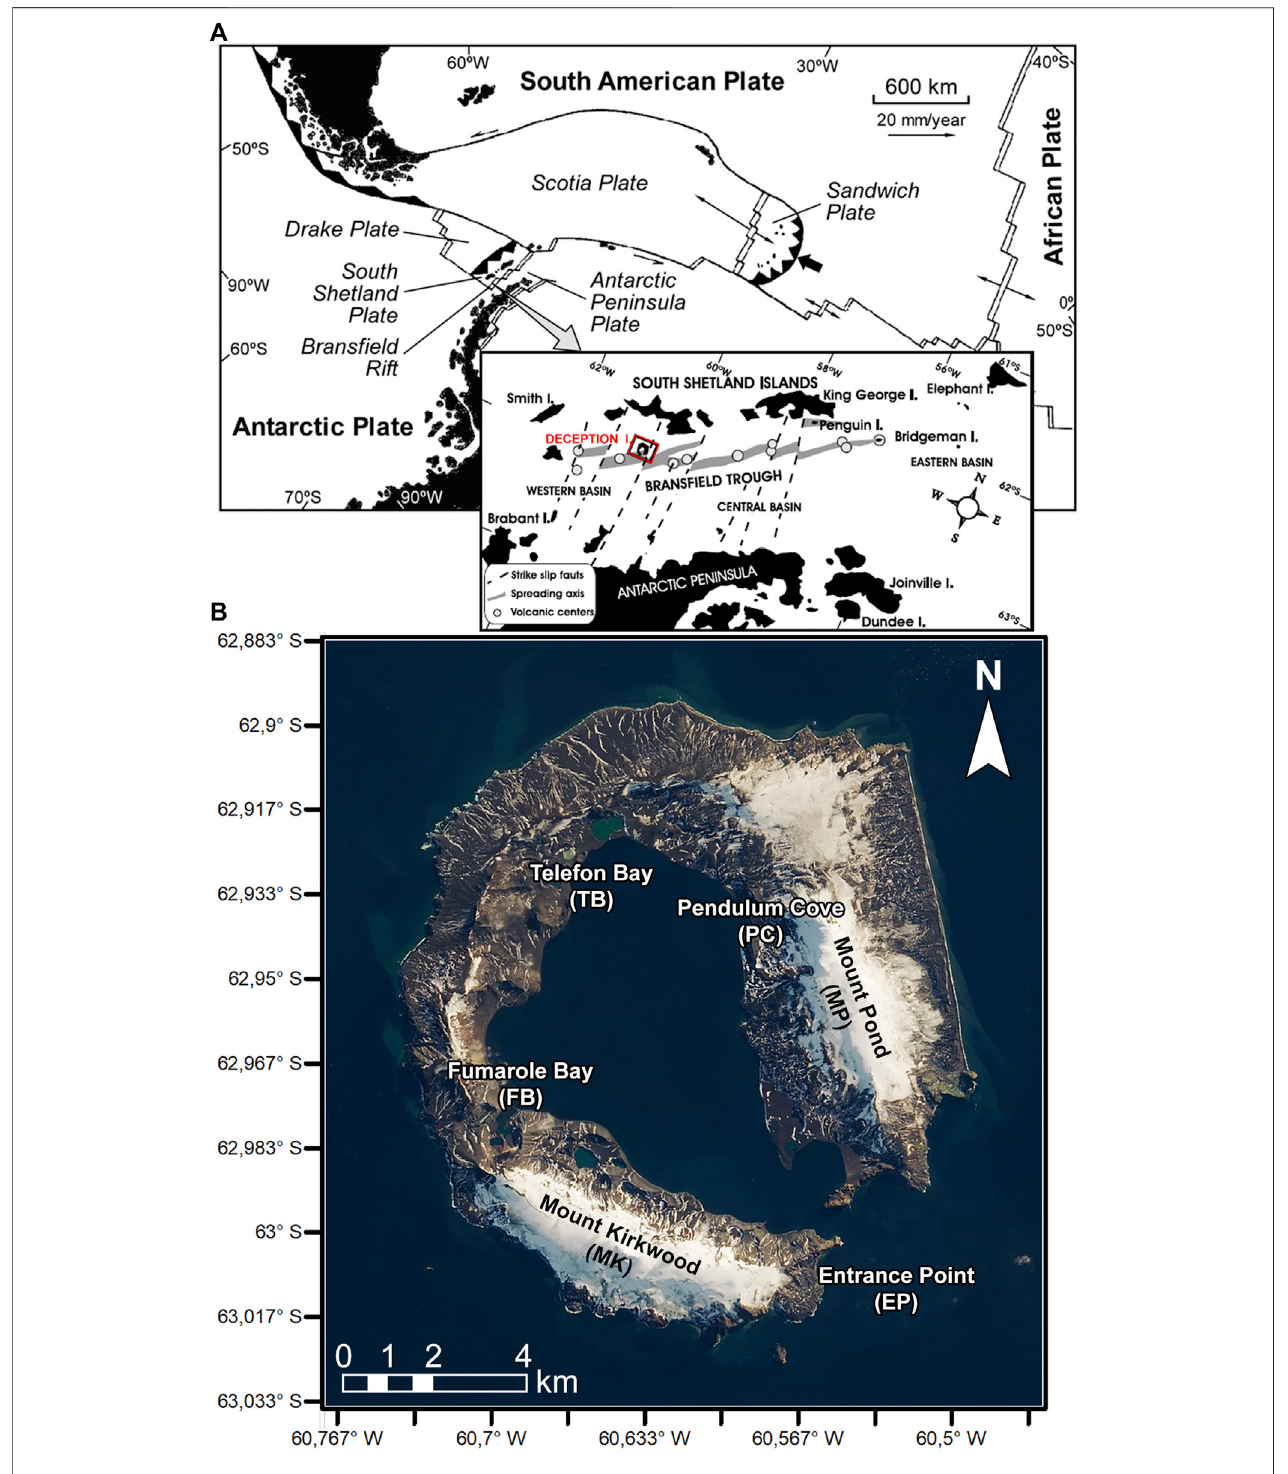
FIGURE 1 | Simpli fi ed regional tectonic map and location of the South Shetland Islands (A) and map of Deception Island with toponymics (B) .